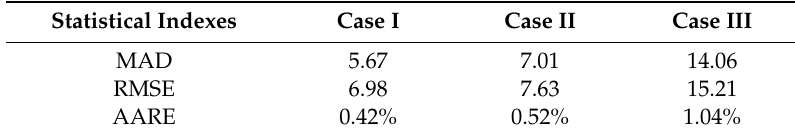
Table 1. Deviation statistics in three cases.